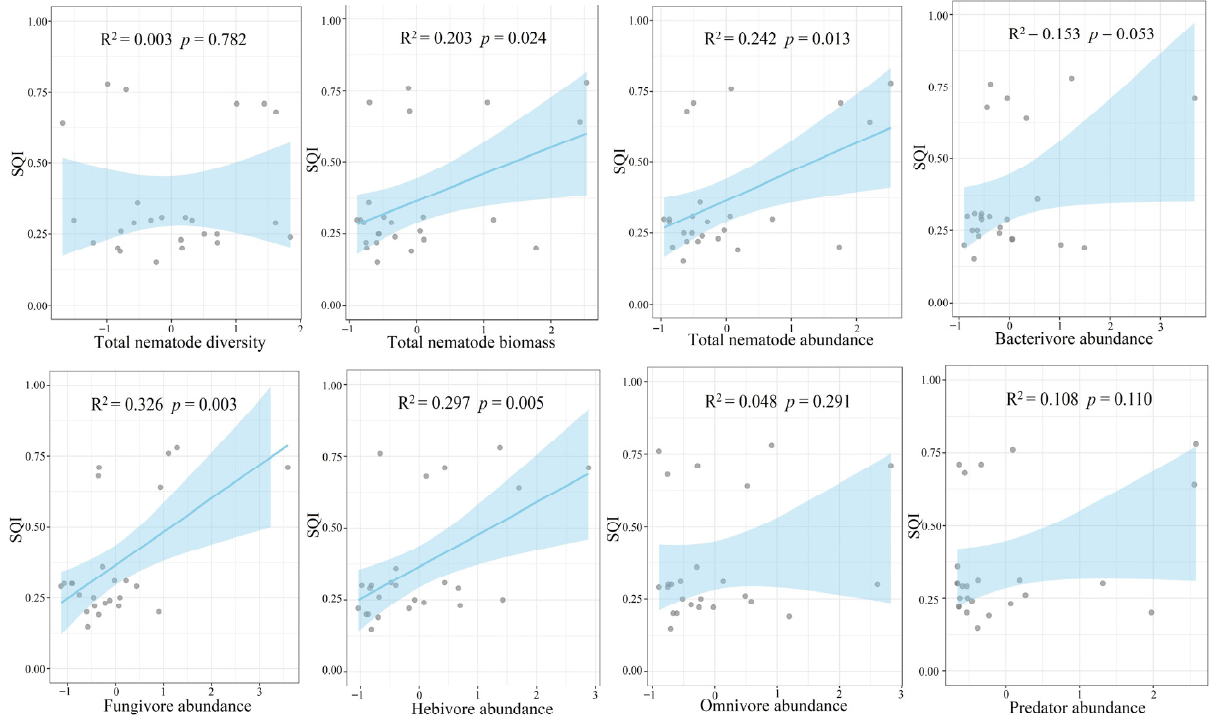
Figure 5. Relationships between SQI and soil nematode properties. Solid line represents a significant linear regression according to an ordinary least squares (OLS) regression model. The area shaded in light blue indicates the 95% confidence interval.